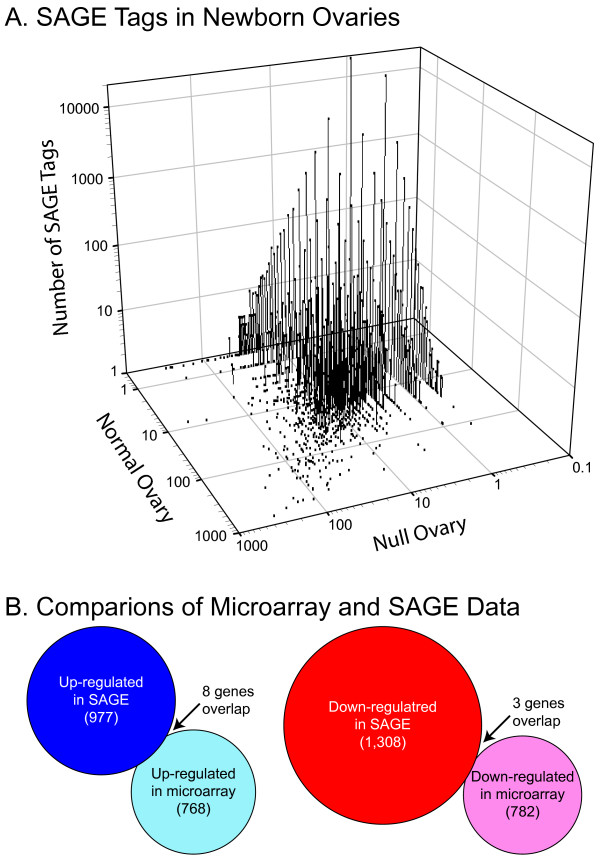
Serial analysis of gene expression. Serial analysis of gene expression (SAGE) of newborn ovaries of normal and Figla null mice. A. Three dimensional plot of the number of SAGE tags (10 bp) in normal and Figla null newborn ovaries. B. Comparison (ρ ≤ 0.05) of transcripts that are up-regulated (blue) or down- regulated (red) by FIGLA in SAGE analysis [20] and by microarray using an FDR threshold of 5% [37]. Size of circles reflects the number of transcripts. Eleven transcripts were detected in both platforms, eight of which were up-regulated (POU5F1, ZP2, IVNS1ABP, VBP1, PADI6, RBPMS2, Genbank:EG626058, 6430591E23Rik) and three of which were down-regulated (SP3, HDAC2, OGT) in newborn normal ovaries.